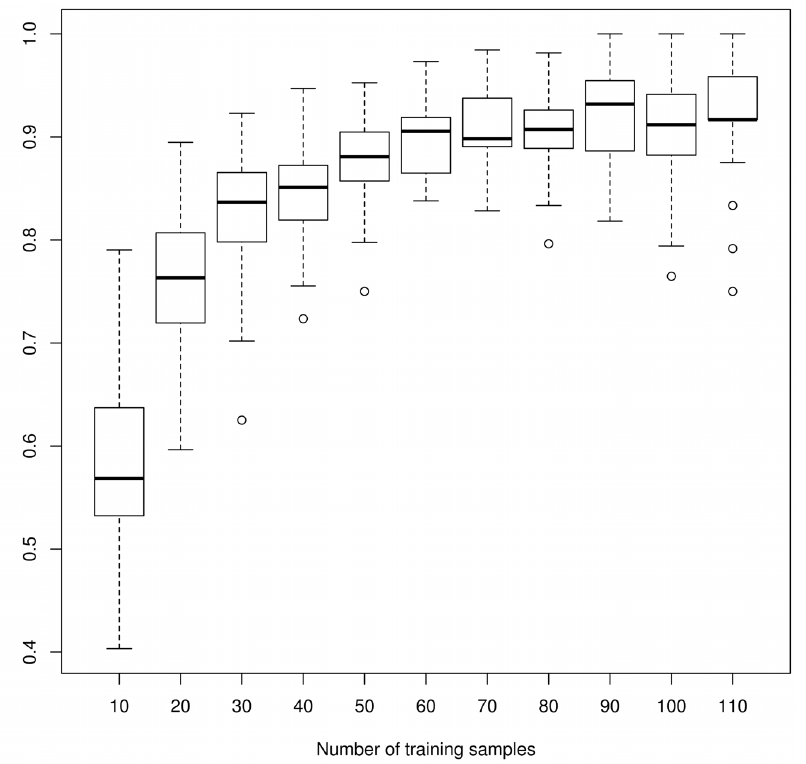
Figure 2. Box-and-whiskers plot showing the mean internal cross-validation accuracy of sex prediction for different sample sizes. Sample sizes tested ranged from n=10 (5 R , 5 = ) to n=110 (55 R , 55 = ). To calculate the mean 10-fold cross validation prediction accuracy, for each n (=10…110), we built classification models using a randomly selected size-n subsamples of our full dataset of n=134. This was repeated 50 times and the median prediction accuracy for each sample was calculated. As sample size increased, so did prediction accuracy.